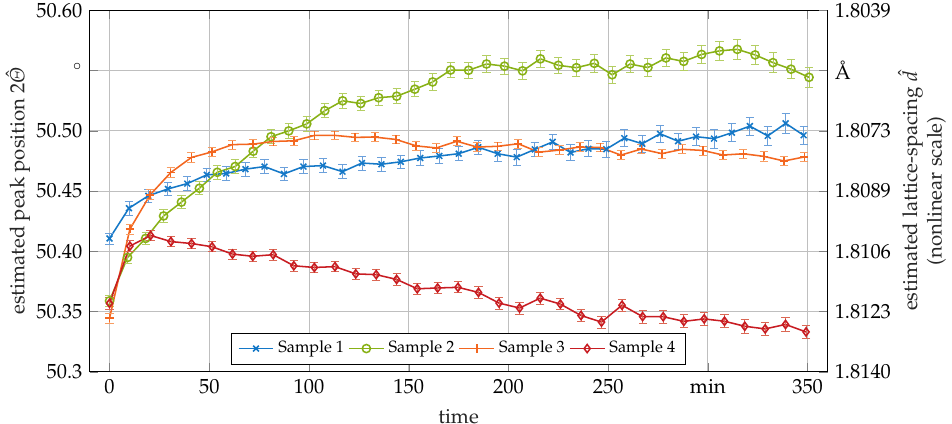
Figure 11. XRD based estimation of peak positions 2 ˆ Θ of the ( 002 ) - γ -peak over the time spent in the HT measured in situ. The estimated lattice spacing was calculated using the Bragg equation. Error bars are related to the 2 ˆ Θ